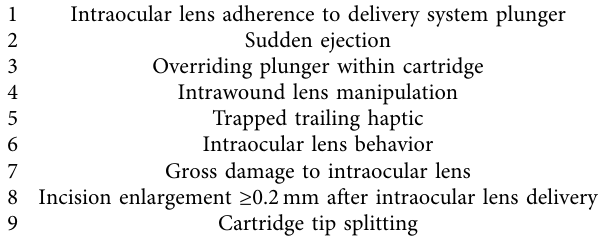
Table 1: Delivery device